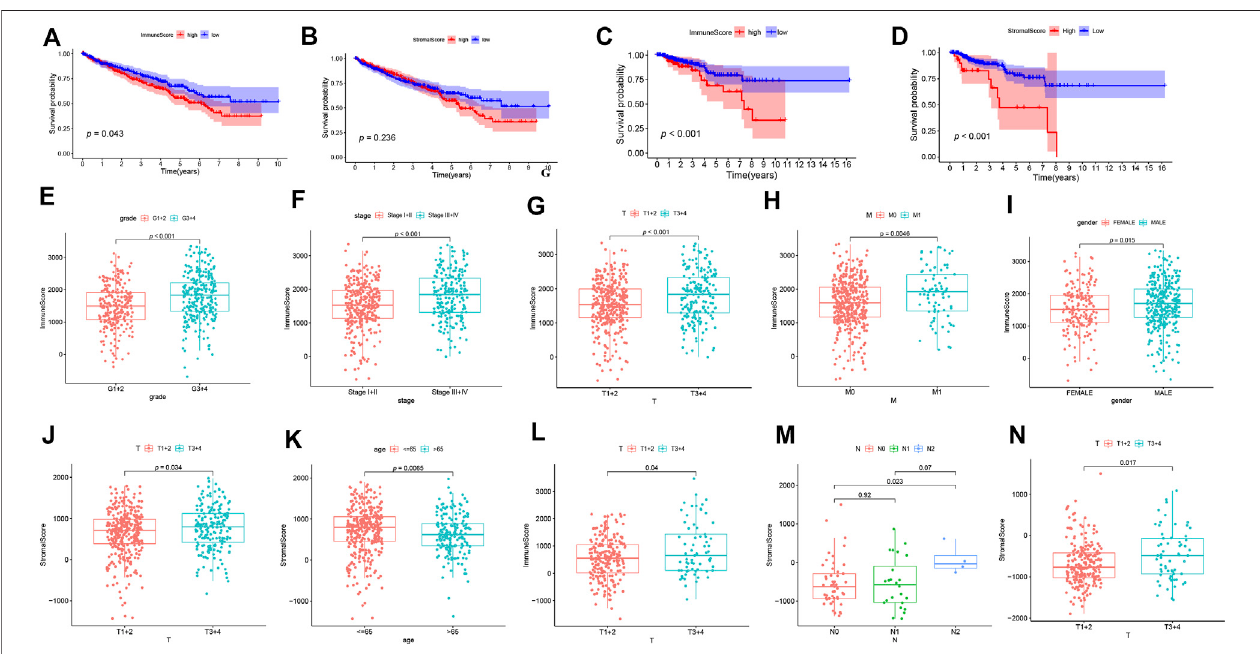
FIGURE1| ThecorrelationanalysisbetweenESTIMATEscoresandprognosisofpatients. (A-D) TheK-McurvesforESTIMATEscoresinccRCC (A-B) andpRCC (C-D) . (E-N) The correlation analysis between ESTIMATE scores and clinicopathological features in ccRCC (E-K) and pRCC (L-N) .